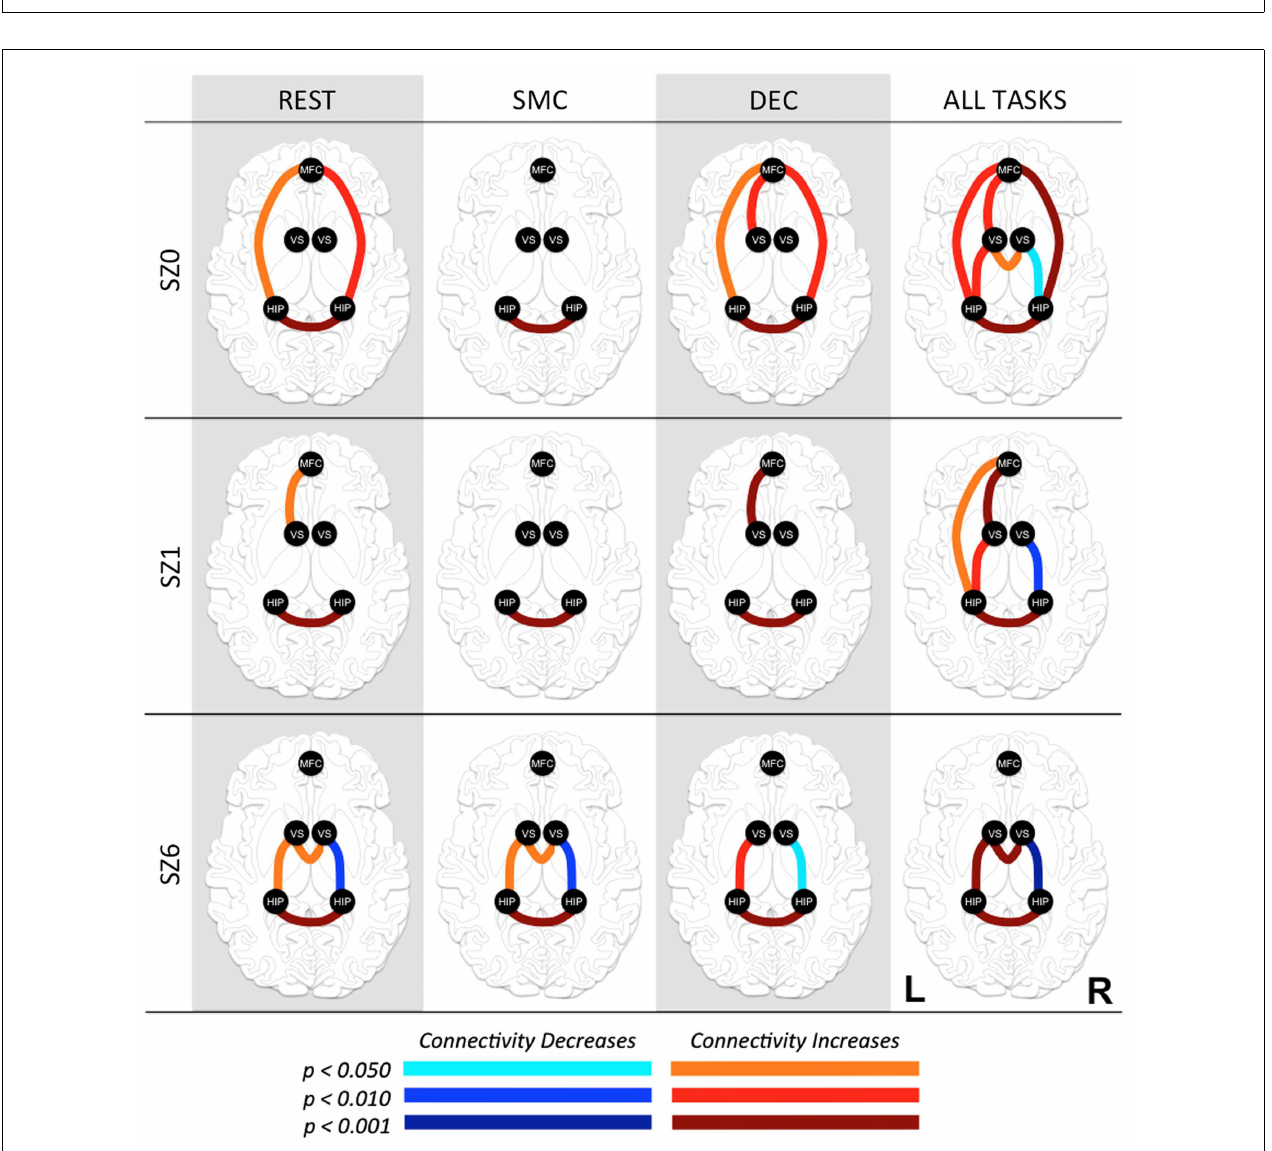
connection between nodes ( p -value), for all connections with p < 0.05. SZ0, baseline; SZ1, 1week of antipsychotic drugs treatment; SZ6, 6weeks of antipsychotic drug treatment; HIP, hippocampus;VS; ventral striatum/nucleus accumbens; MFC, medial frontal